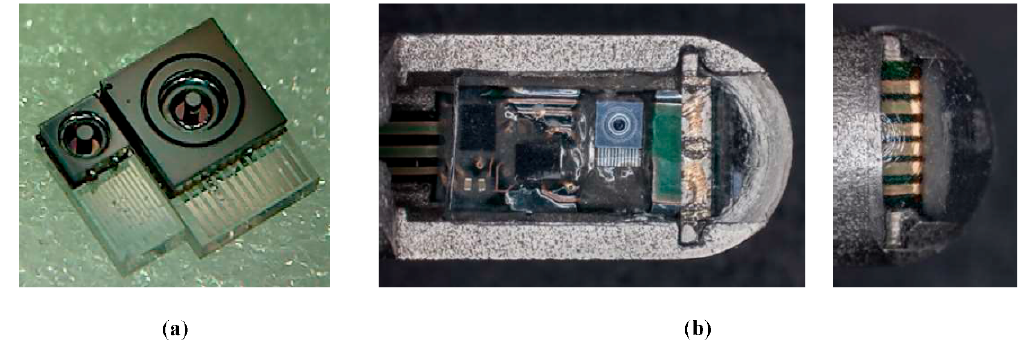
Figure 1. Individual force sensor chips before mounting and wire bonding ( a ): 1 × 2.5 mm 2 chips for head mounted tactile sensing (left) and 2 × 3 mm 2 for gripping force (right). The medical grade stainless steel laparoscopic tweezers with the integrated electronics covered in the (transparent) flexible biocompatible elastomer ( b ).